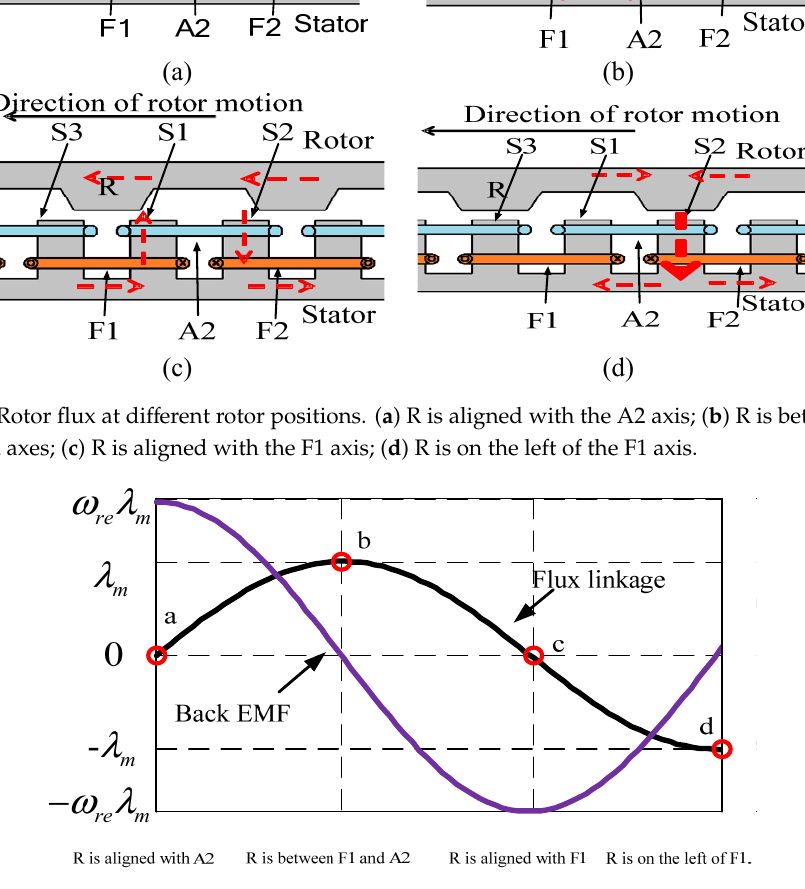
Figure 3. Flux linkage and back-EMF waveforms.